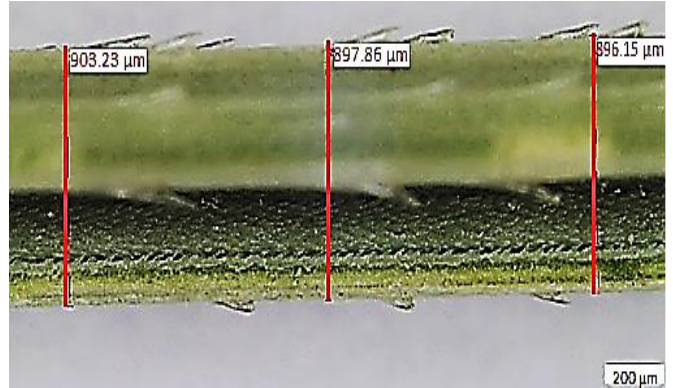
Figure 2. Observation by optical microscope: diameter measurement of the Diss fibers. As shown in Figures 2 and 3, the sections of the fibers do not have a regular geometric shape. Diss leaves come in a coiled form and take on a shape that approximates an ellipse with a spiked surface. The outer surface of the Diss fiber is spiny. In addition, the inner surface is covered with spines, which are evenly distributed and have visible ridges covered with fine tangled needles. Figure 5 demonstrates that the Diss fibers have rough surfaces showing the different reliefs observed to clearly appear in the spins, which allows them to have a better anchoring in a soil